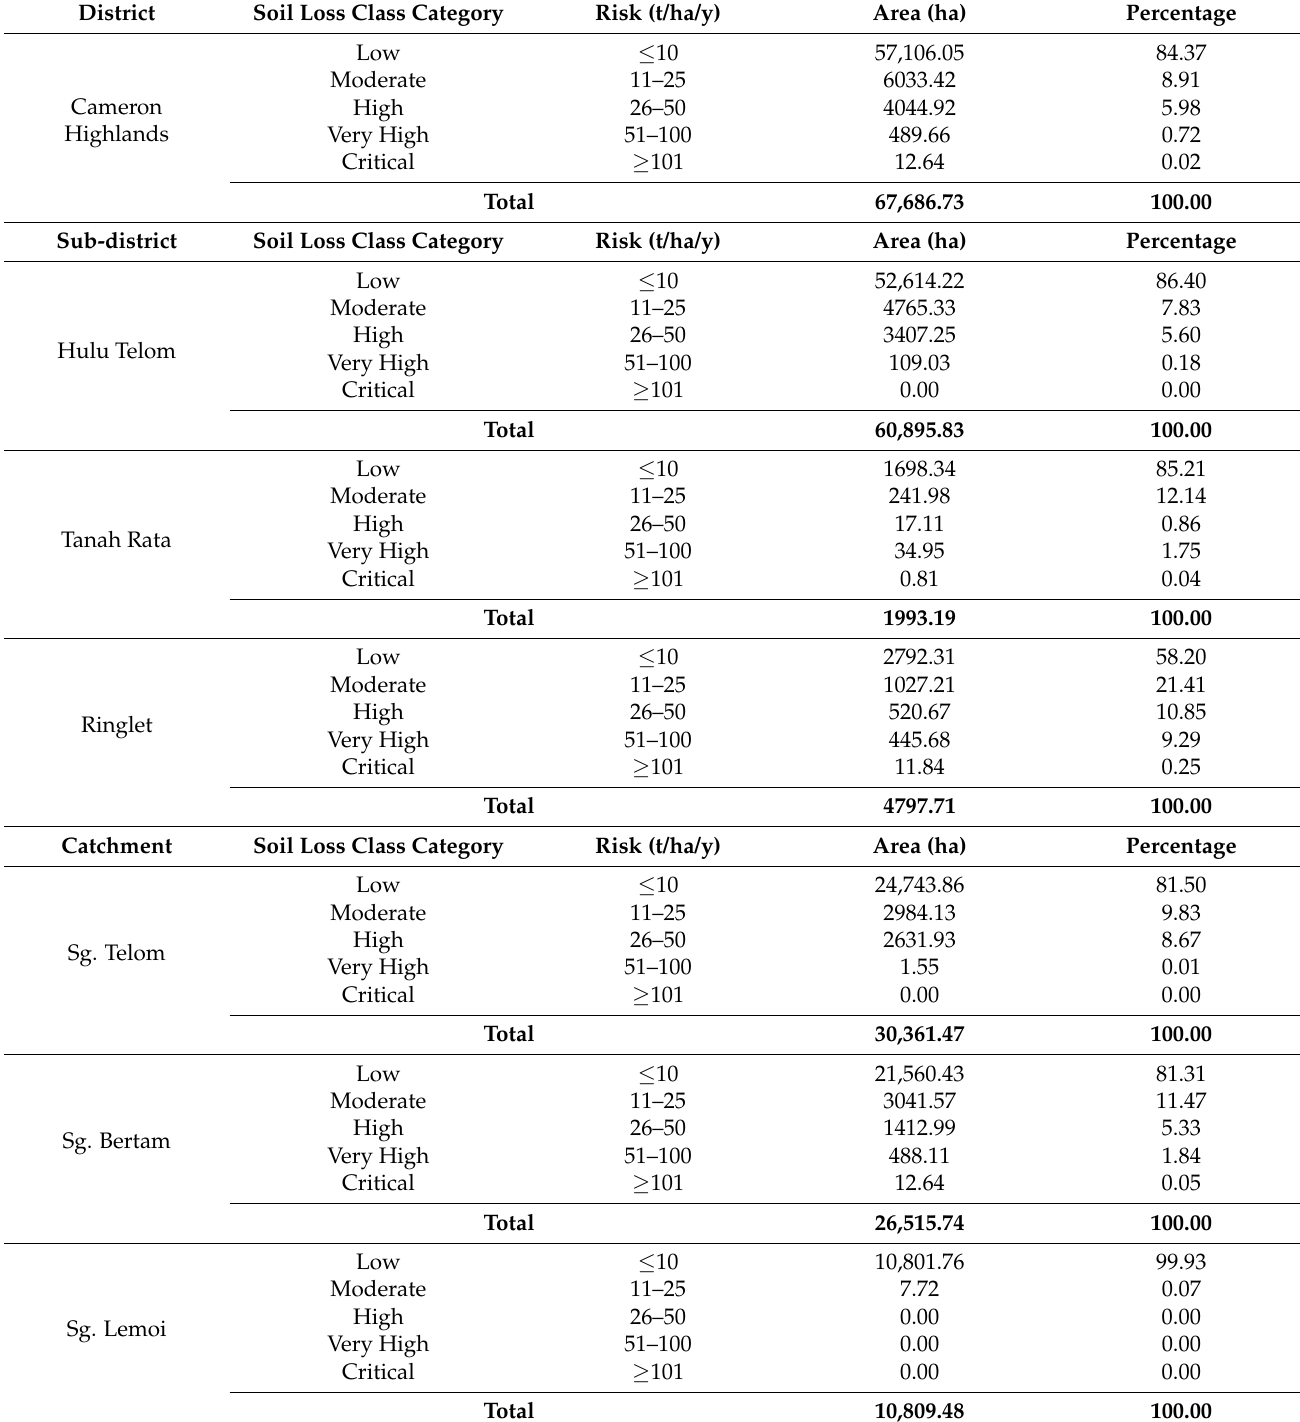
Table 8. Area and percentage of soil loss risk level in Cameron